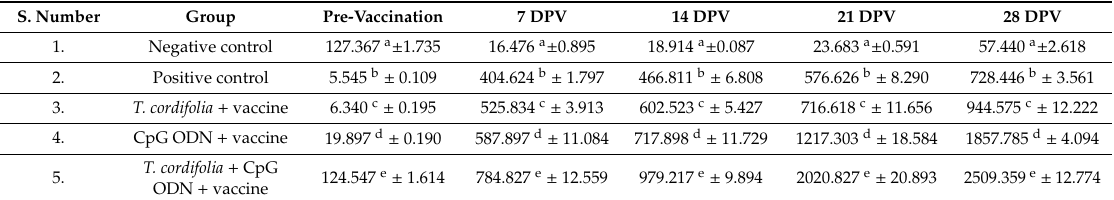
Table 15. Serum antibody titers (mean ± SE of antilog of Log 10 titer) in chickens vaccinated with IBDV vaccine at di ff erent DPV by ELISA kit method.